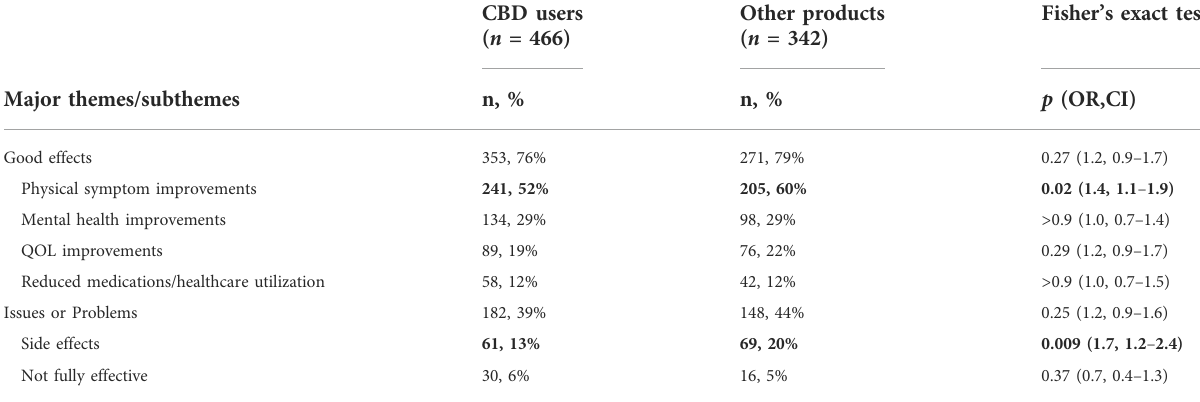
TABLE 4 Product related (CBD vs other) differences in medical cannabinoid